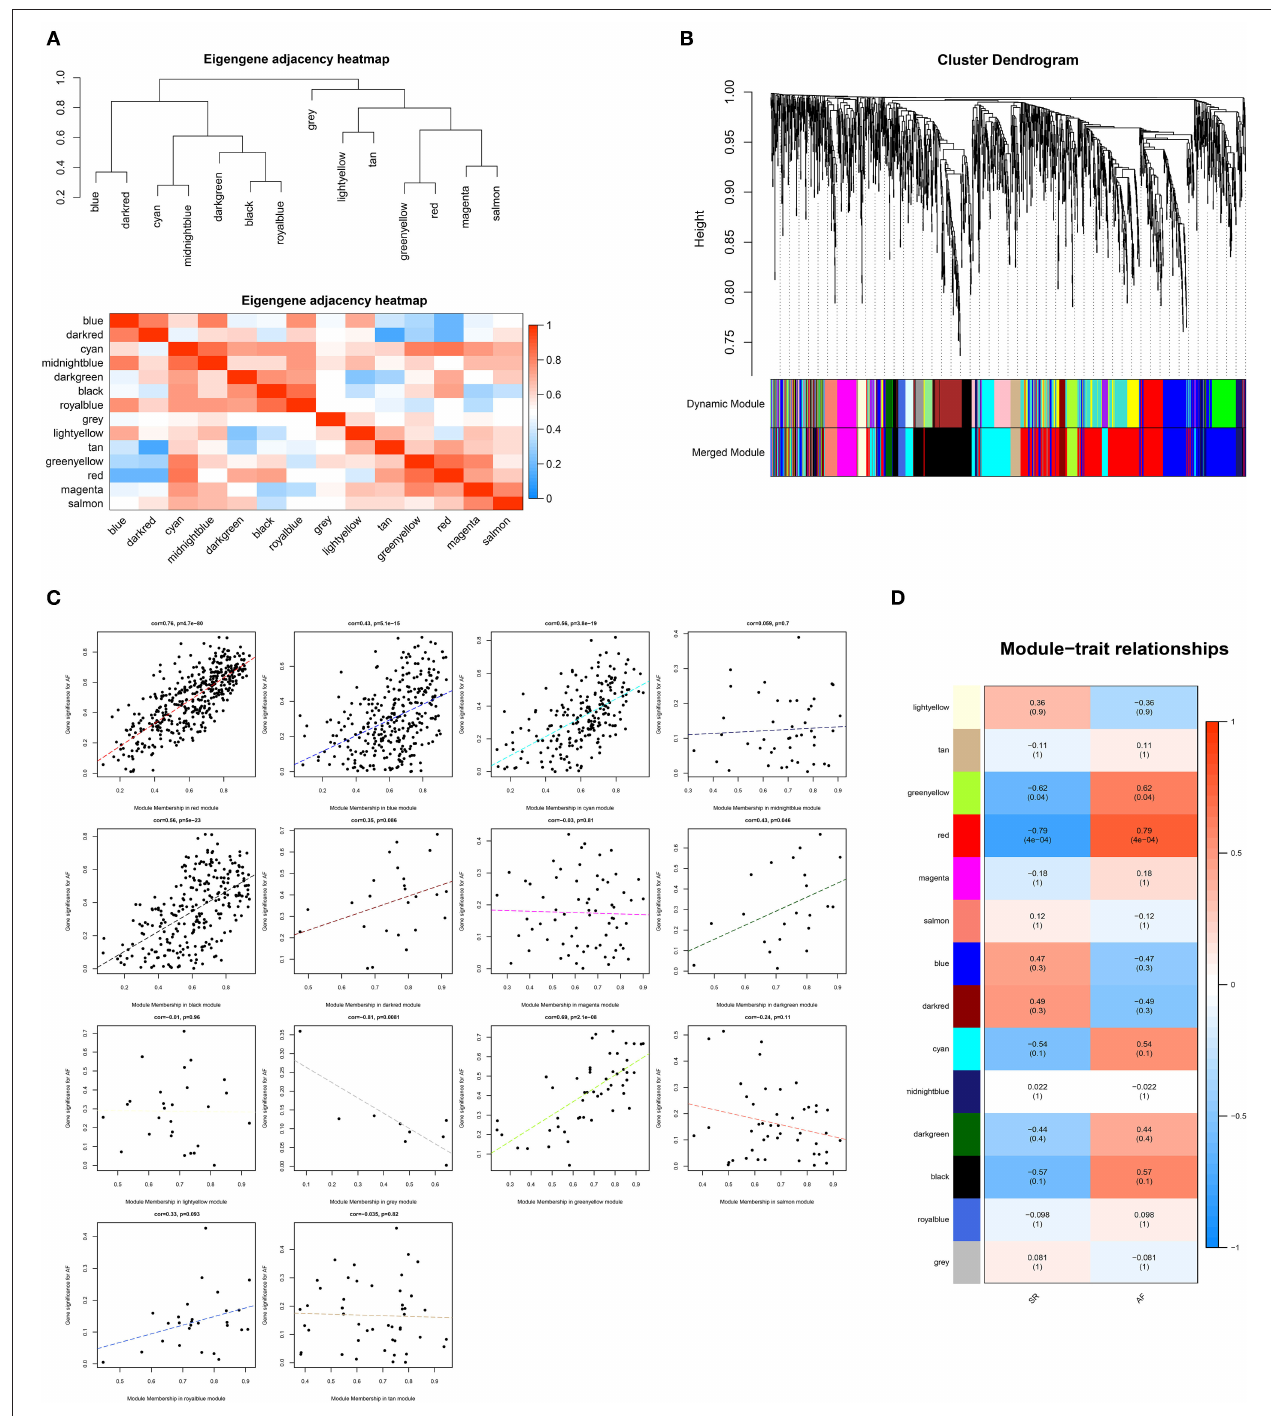
FIGURE 1 | Weighted genes correlation network analysis. (A) The clustering heatmap between modules. Red means closer similarity and blue means farther similarity. (B) The dendrogram of differentially expressed genes. (C) The correlation between module memberships and the gene significance for atrial fibrillation. The abscissa represents the module membership in each module. (D) The heatmap of module-trait correlations. Blue represents negative correlation, and red represents positive correlation.